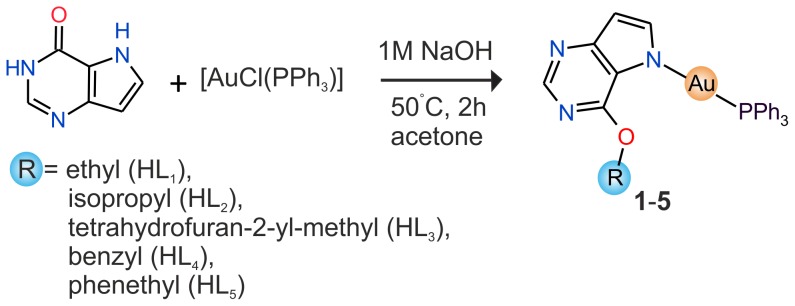
A pathway for the preparation of complexes 1–5.